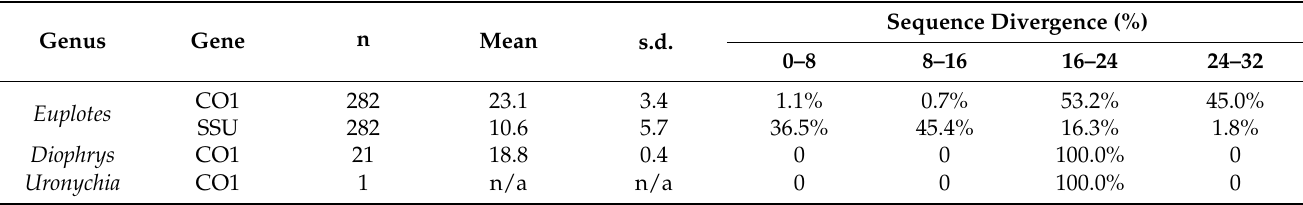
Figure 1. SSU rDNA and CO1 sequence divergences for 282 congeneric pairs of Euplotes species. Table 2. Mean and standard deviation (s.d.) of the percentage sequence divergences of CO1 or SSU rRNA genes for congeneric species pairs within three genera. (The percentage of sequence divergence estimates falling in a particular range is also shown. n indicates the number of congeneric pairs examined in each genus).